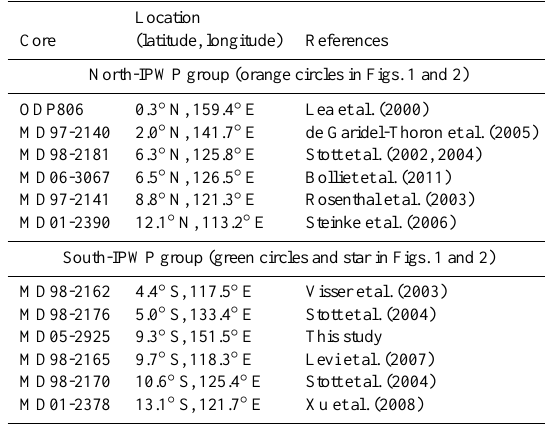
Table 2. Selected sites for stacked N- and S-IPWP records. Location Core (latitude, longitude)